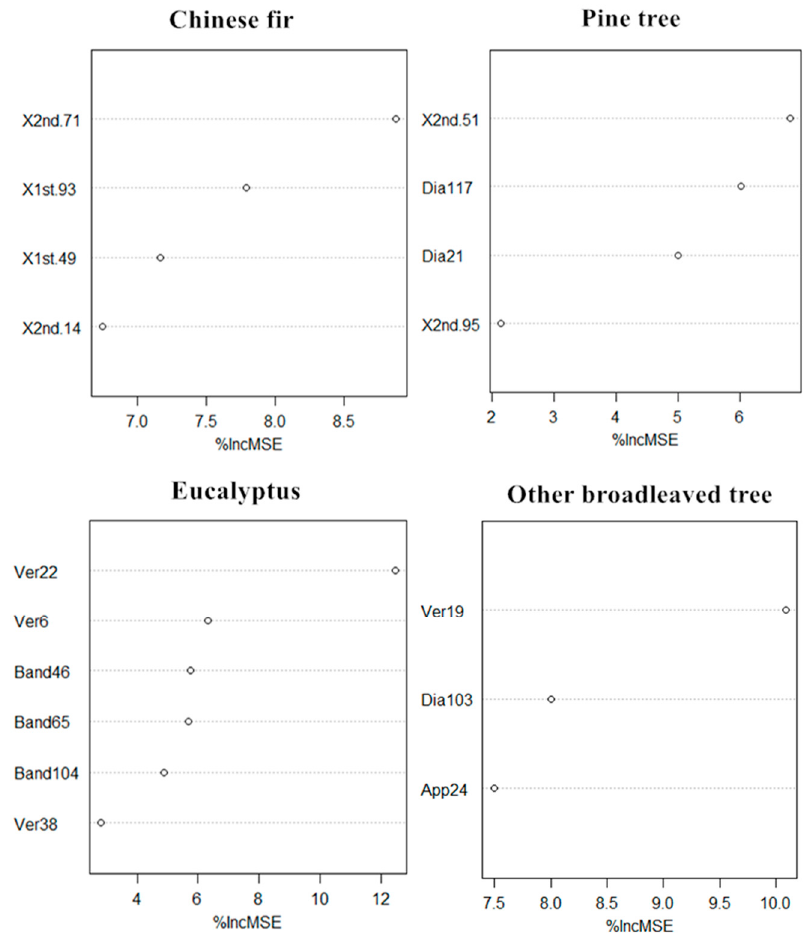
Figure 4. The feature importance ranking map after two-level screening of hyperspectral features.